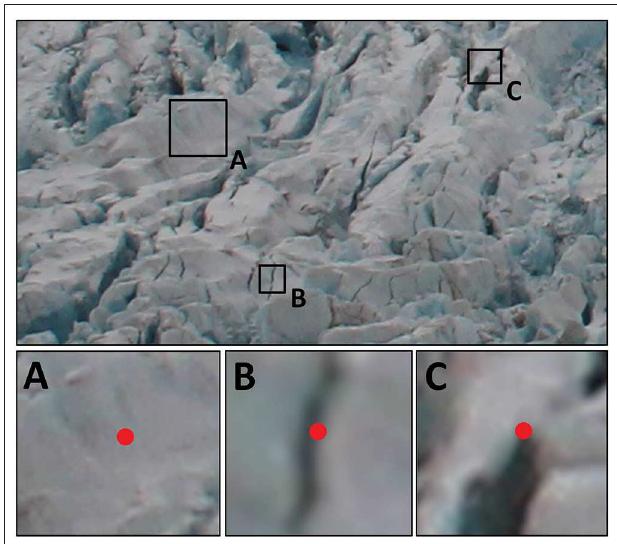
FIGURE 6 | Corner feature coherency demonstrated using regions of a time-lapse image of a crevasse field. The crevasse field (top image) is a subset of a time-lapse image from Kronebreen, Svalbard. The regions highlighted from this subset are examples of a homogeneous area (A) , an edge feature (B) , and a corner feature (C) . At the red point in (A) , there is an indistinctive pixel pattern that could not be matched from image to image. The red point in (B) has a distinct boundary between different pixel intensities, but tracking may drift along the boundary over time. The red point in (C) is a very distinctive pixel pattern with a defined corner feature that is easy to